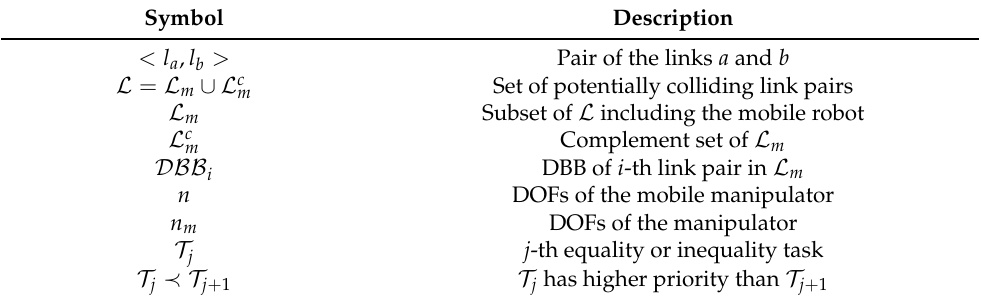
Table 1. Notation and symbols.